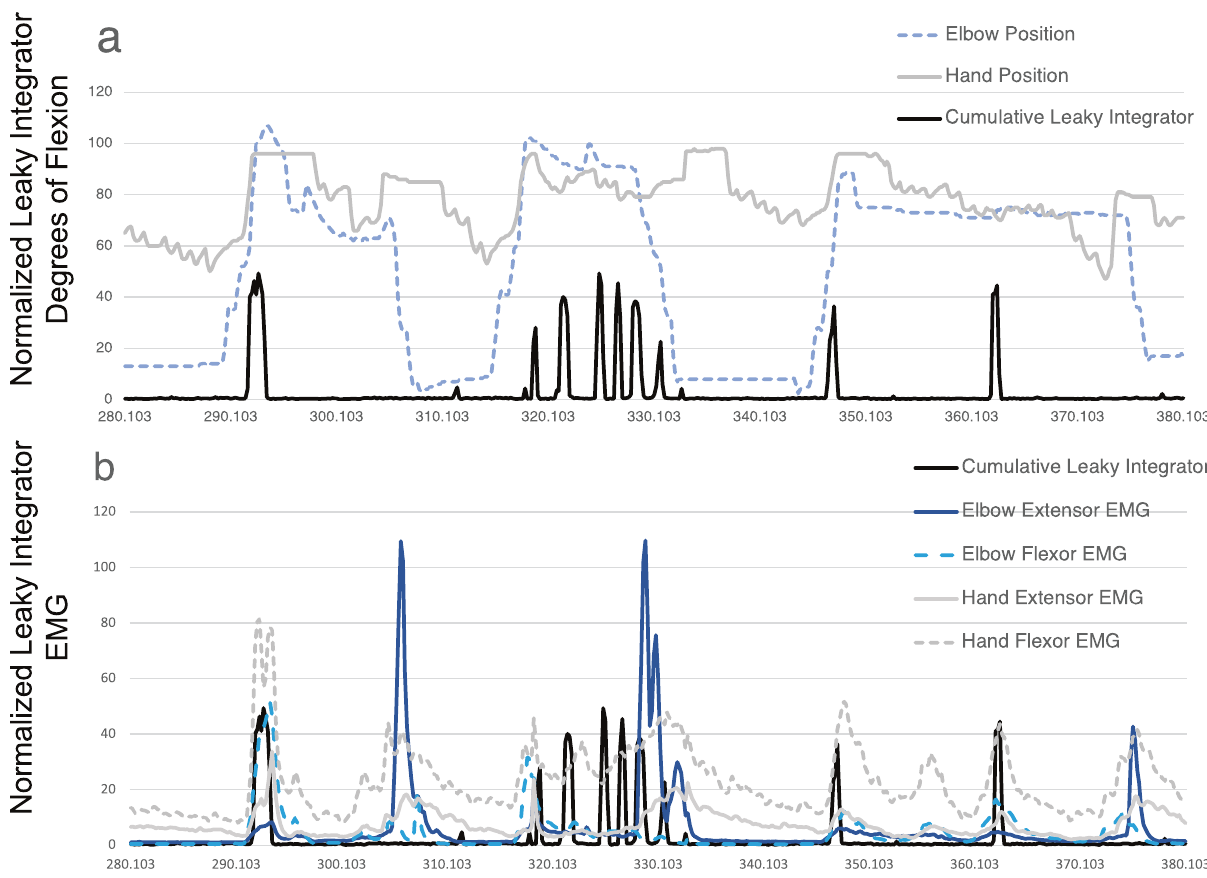
Fig. 6 Cumulative, integrated spike activity across channels and simultaneous joint position and electromyographic activity. The integrated neural activity fl uctuated with joint position and residual left forearm electromyographic activity. The summed spike activity across channels and run through a leaky integrator 29 (solid black line) appeared to fl uctuate with speci fi c residual actions in the left upper extremity ( a ). Proximal residual activity generated a normal appearing pattern as seen between 290 and 310 s, biceps (dashed light blue line) and triceps (solid dark blue line) activity alternate ( b ). In the distal upper extremity, however, wrist fl exor (dashed gray line) and wrist extensor (solid gray line) activity, tend to occur simultaneous in an abnormal manner (simultaneous agonist and antagonist contraction); also, wrist fl exor activity is abnormally synergistic with biceps activity (an abnormal fl exor synergy). The summed, integrated spiking activity across channels (black line) appears to covary with wrist fl exor activity. Numerical data that was used to generate this fi gure is available in Supplementary Data